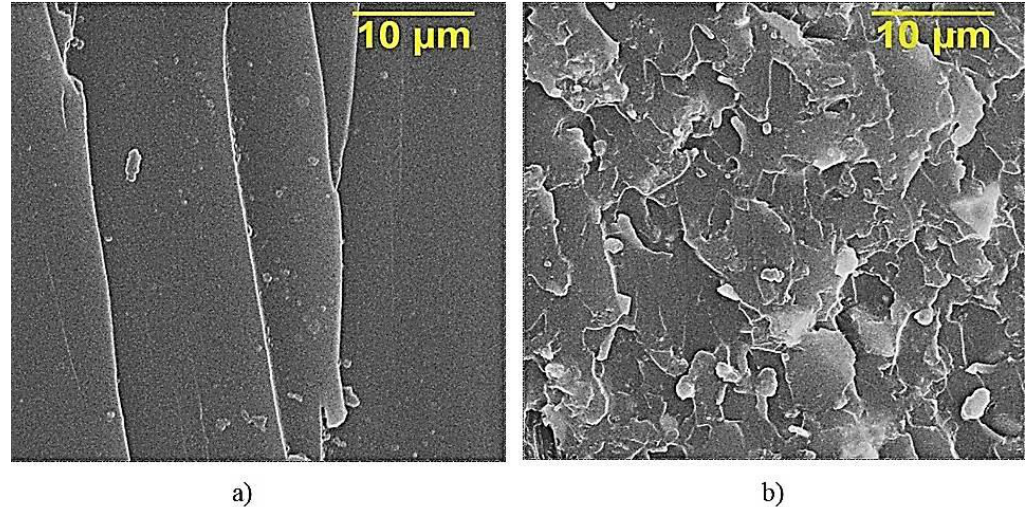
Figure 7. SEM of the surface of the destruction of epoxy composites: ( a )—without ocher; ( b )—with 75 parts by mass of ocher, relative to ED-20.